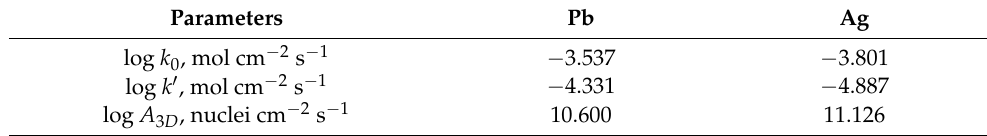
Table 1. Lateral and vertical growth rates and nucleation rates constant